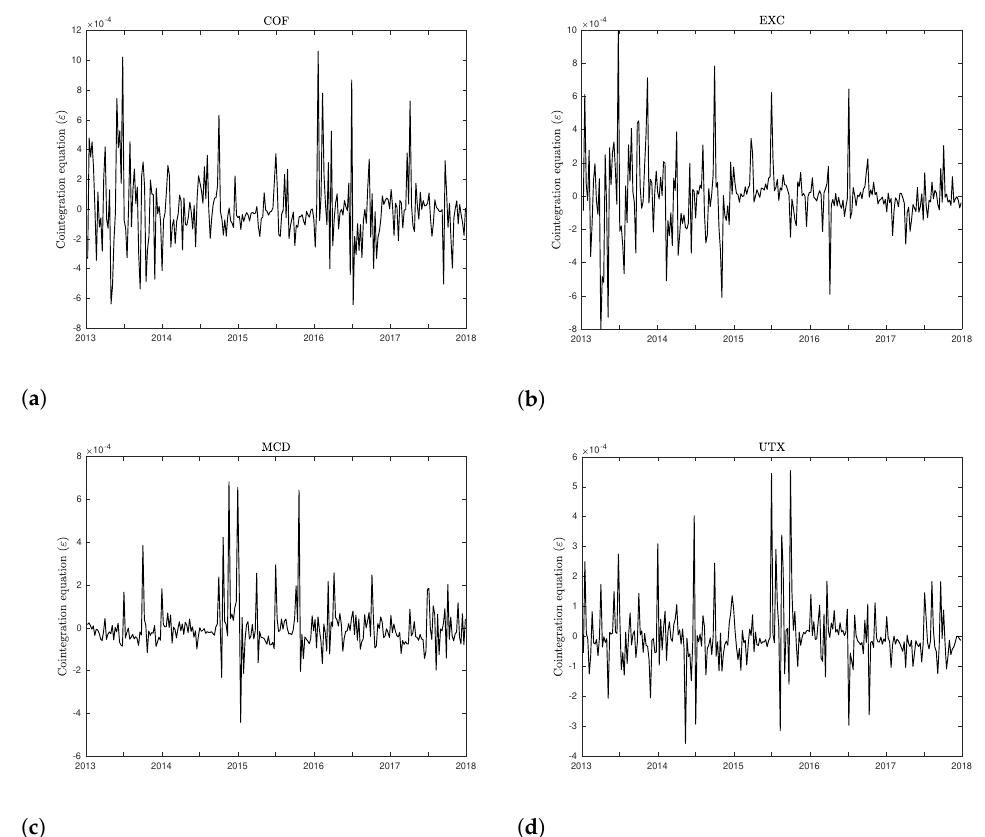
Figure 3. Cointegration equations (residuals of regression (11)) for four different companies: Capital One Financial (financials), Exelon (mining, energy and utilities), McDonald’s (retail, wholesale and services), and United Technologies (manufacturing). Visual inspection suggest stationarity, and therefore cointegration of CDS spreads, leverage, volatility and the treasury yield. Unit root tests confirm the stationarity of the residuals. ( a ) Financials; ( b ) mining, energy and utilities; ( c ) retail, wholesale and services; ( d )